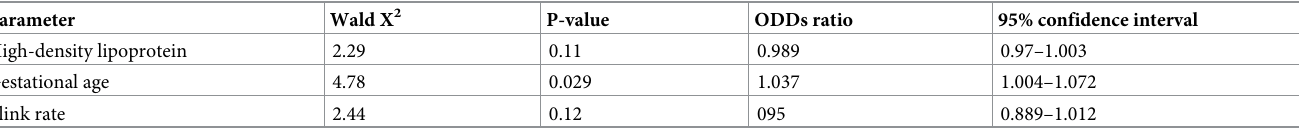
Table 3. Multivariate binary logistic regression